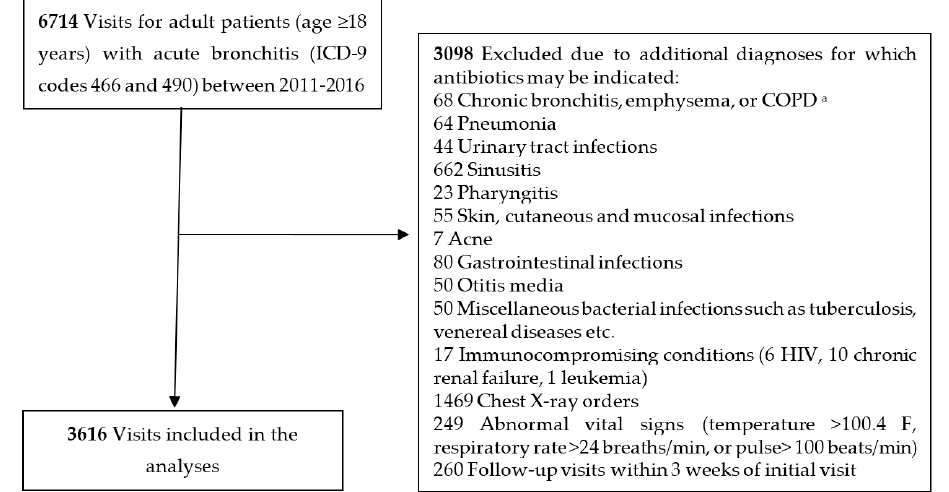
Figure 1. Selection process used to determine visits with uncomplicated acute bronchitis. a COPD: chronic obstructive pulmonary disease.